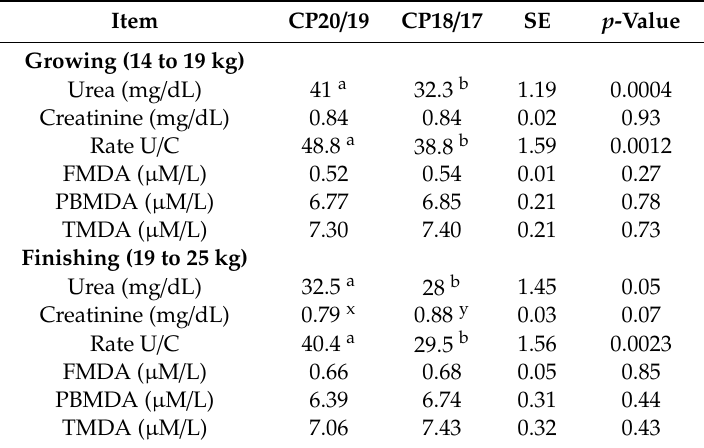
Table 6. E ff ect of Experimental Diets on Metabolites Related to the Protein Nutritional Status and on the Oxidative Status of the Lambs.